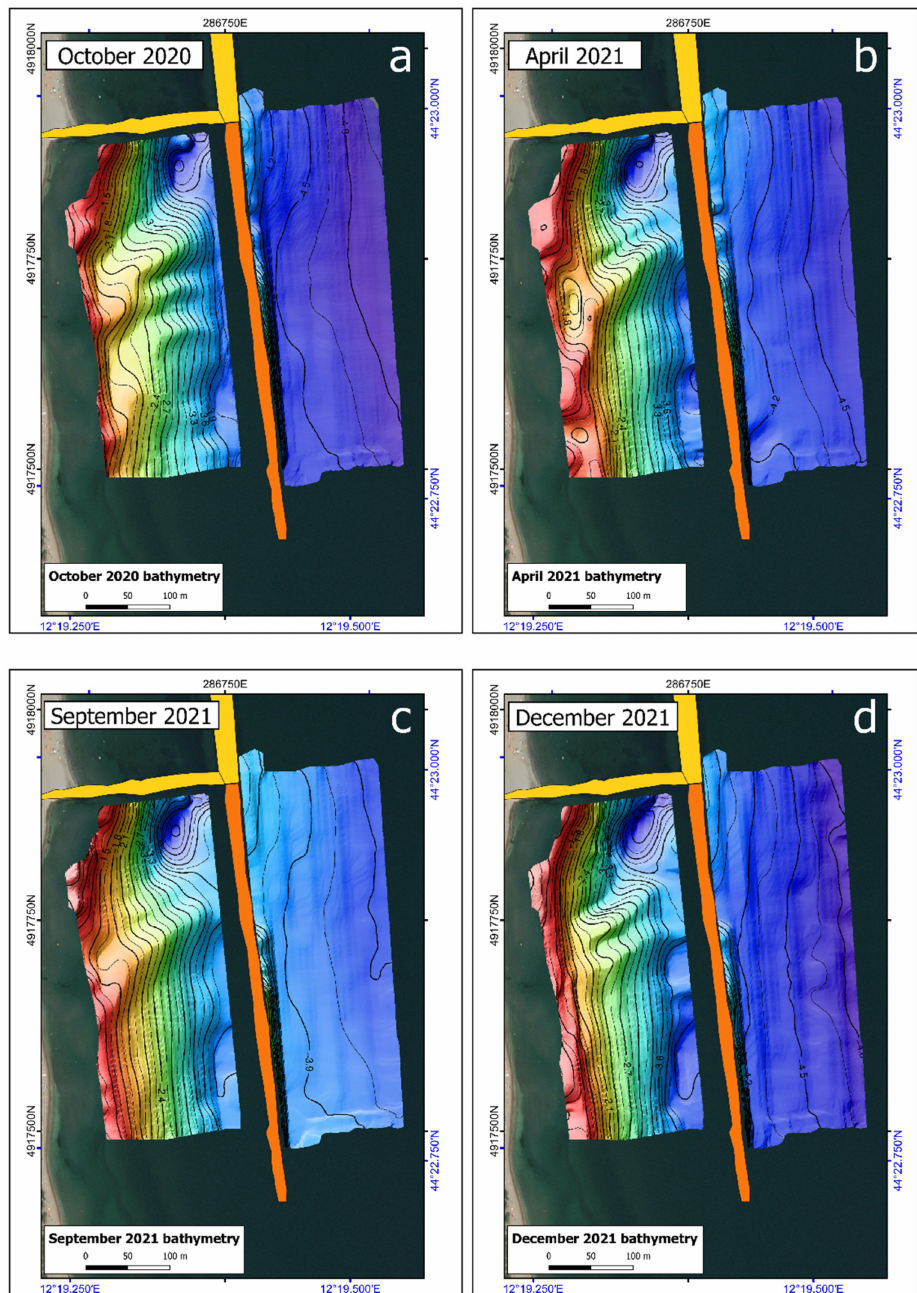
Figure 6. Shaded relief morphobathymetric maps of the seafloor collected between October 2020 and December 2021 ( a – d ), along the same acquisition tracks in the study area. See also Bathy4D.mp4, Supplementary